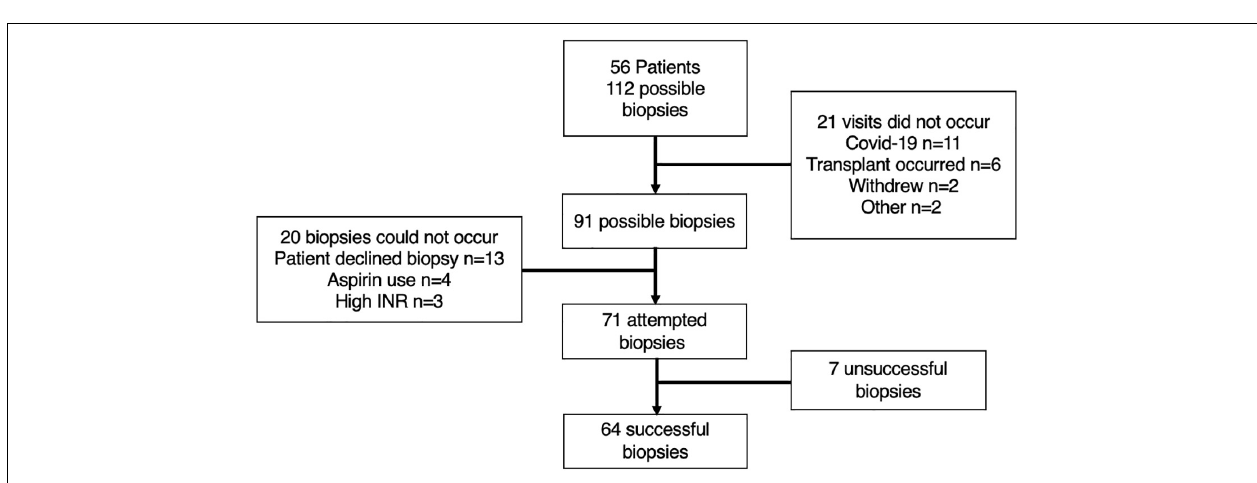
FIGURE 3 | Schematic representation of included patients and visits. The reasons for either the non-occurrence of visits, contraindications for biopsy and unsuccessful muscle biopsies are explained within the attached